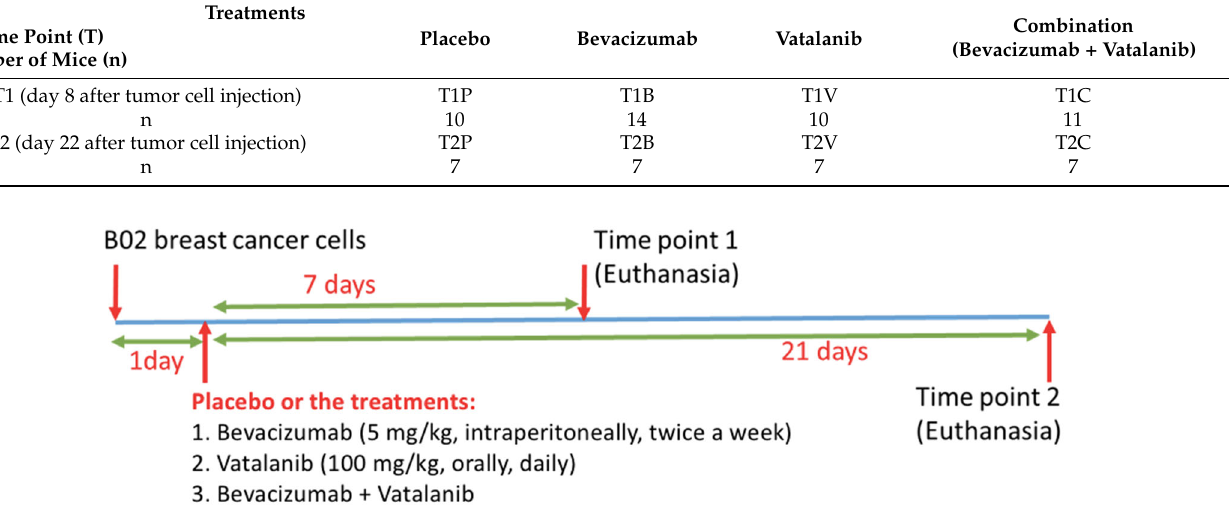
Table 1. Experimental groups according to the time points and types of treatment.